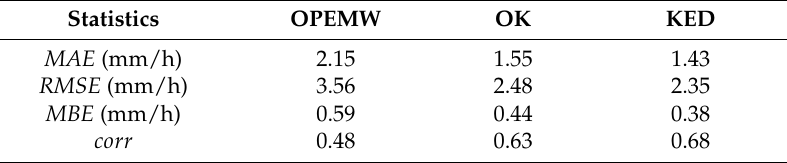
Table 4. As in Table 3 but for data from date 12 Jan 2018 at 06:54 UTC.